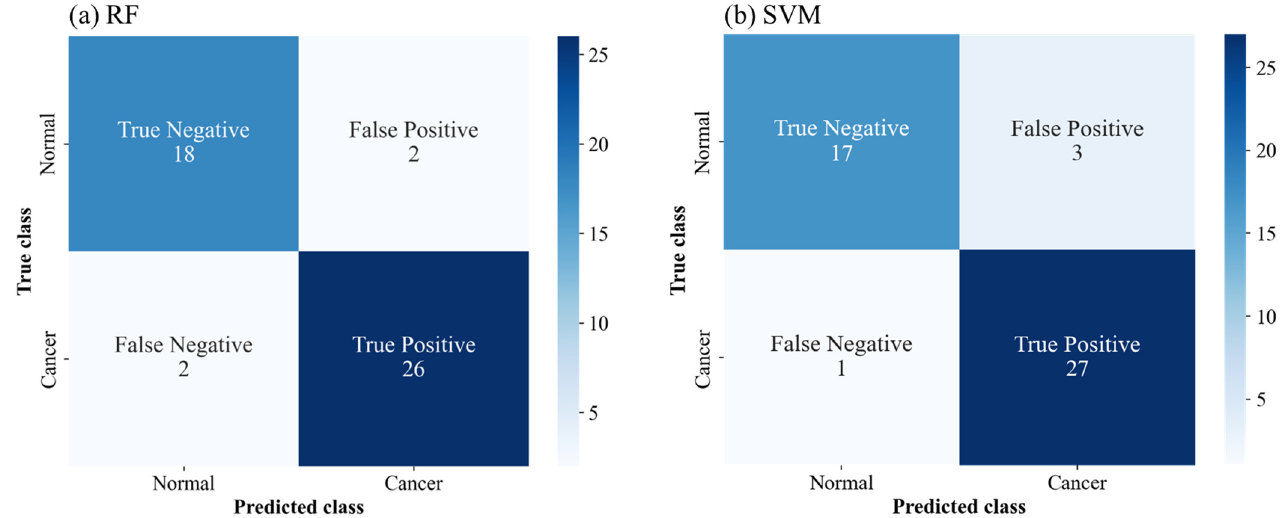
Figure 9. Confusion matrices on the test data for ( a ) RF and ( b ) SVM. RF is more precise and specific compared to SVM, while SVM has the superior F1 score.